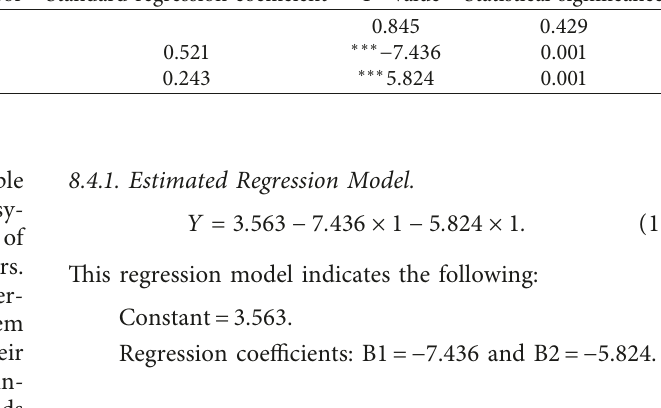
Table 8: Multiple regression coefficients and their statistical significance for psychological flow and psychological resilience.